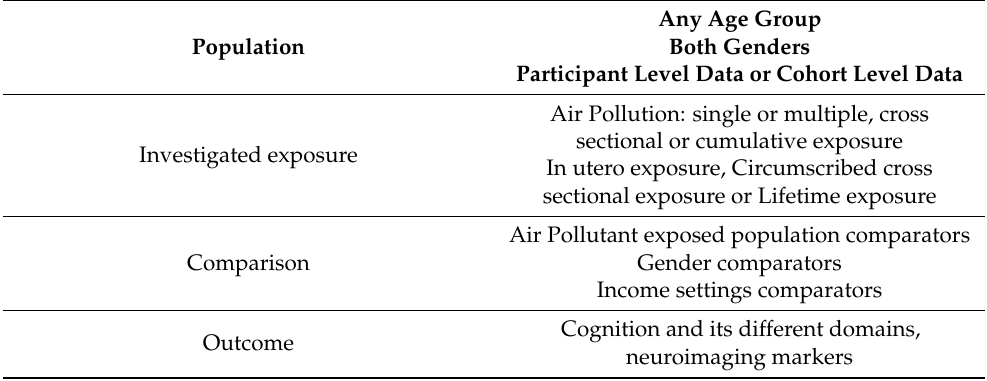
Any Age Group Both Genders Participant Level Data or Cohort Level Data Air Pollution: single or multiple, cross sectional or cumulative exposure In utero exposure, Circumscribed cross sectional exposure or Lifetime exposure Air Pollutant exposed population comparators Gender comparators Income settings comparators Cognition and its different domains, neuroimaging